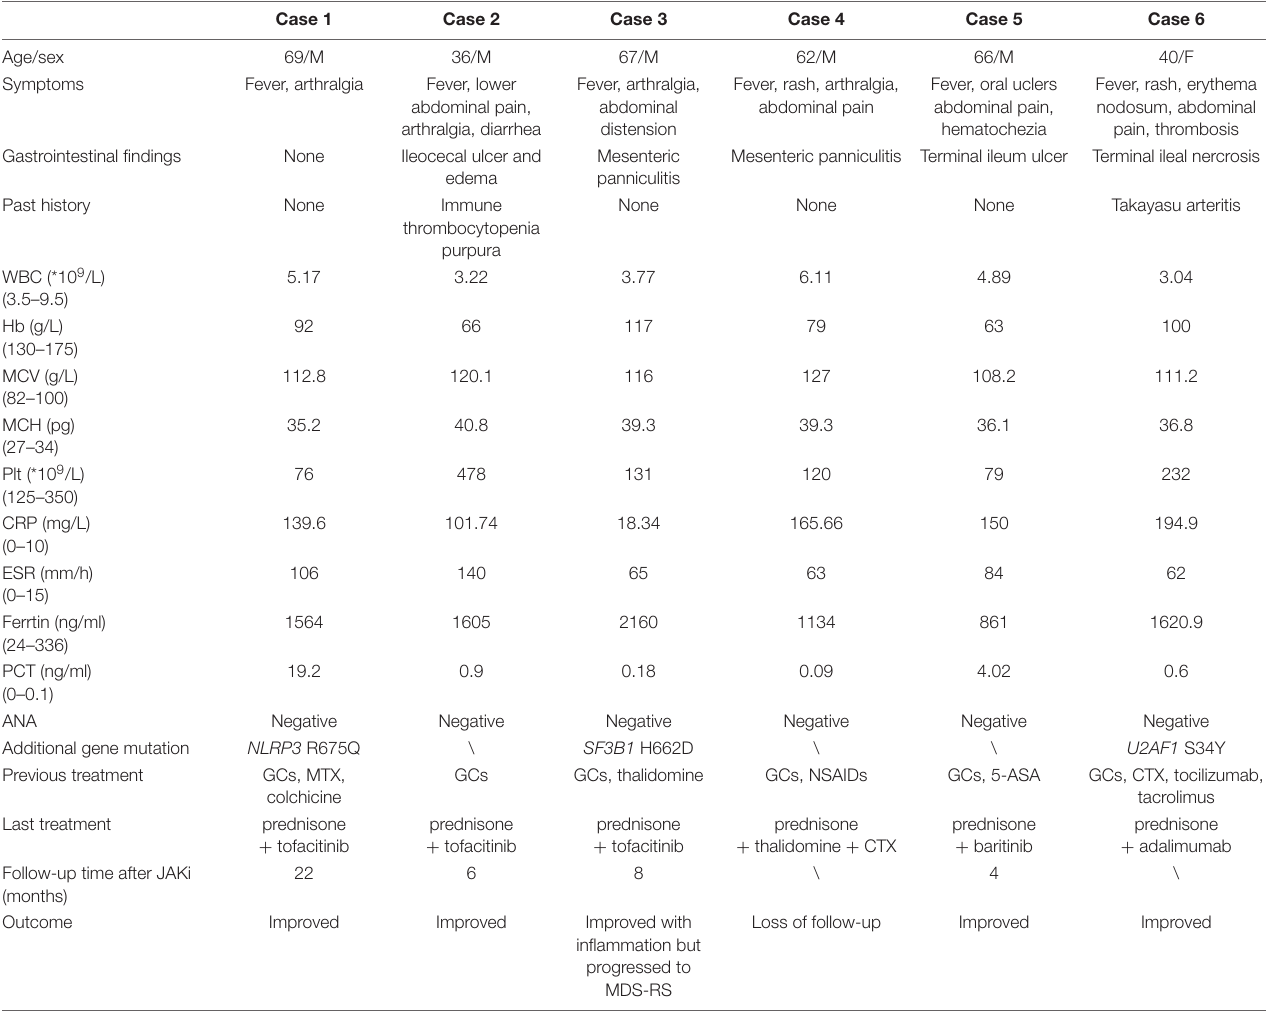
TABLE 1 | The clinical and laboratory findings in